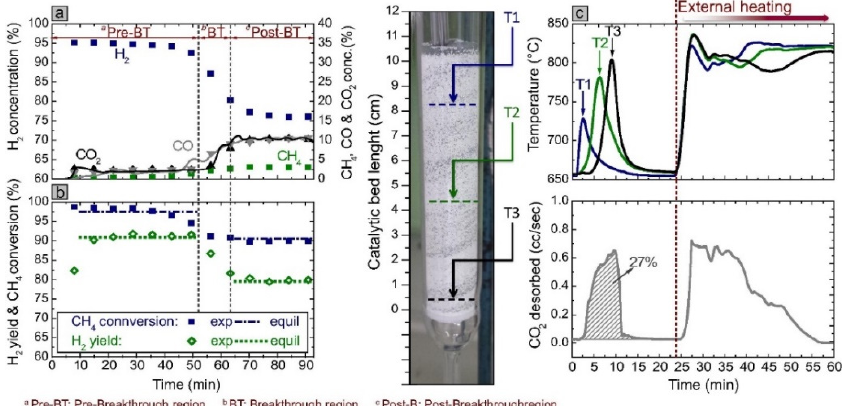
Figure 14. ( a ) Outlet concentrations, and ( b ) yield of H 2 and CH 4 conversion versus time during reduction-steam reforming-carbonation. ( c ) CO 2 formation and temperature profiles versus time during re-oxidation/calcination (reduction-reforming-carbonation: T = 650 °C, Steam/Carbon ratio = 3, NiO/CaO molar ratio = 0.5, GHSV = 250 h − 1 ; T during regeneration: 650 → 800 °C, air flow, GHSV = 430 h − 1 ) [80].